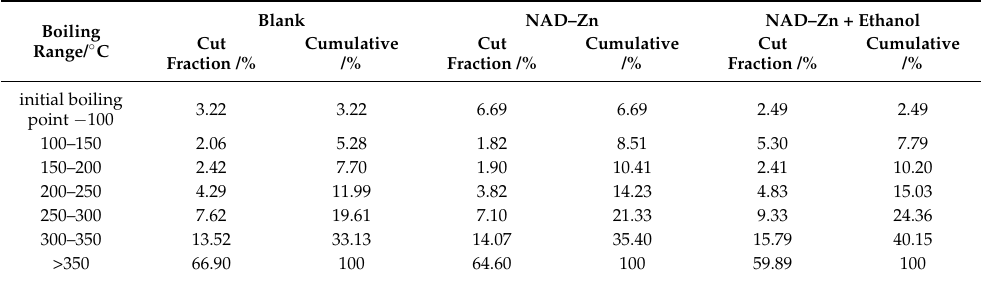
Table 3. Boiling range of heavy oil before and after the aquathermolysis.